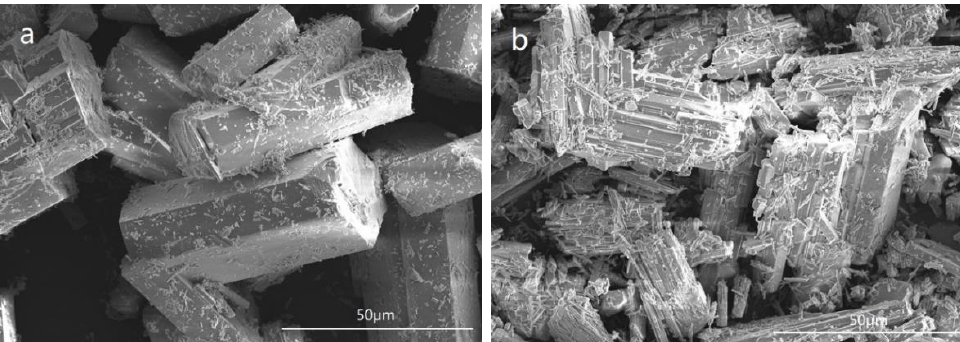
Figure 5. The morphology of hemihydrate gypsum prepared from dihydrate gypsum contained 15 wt% ( a ) and 0 ( b ) of attachment water.